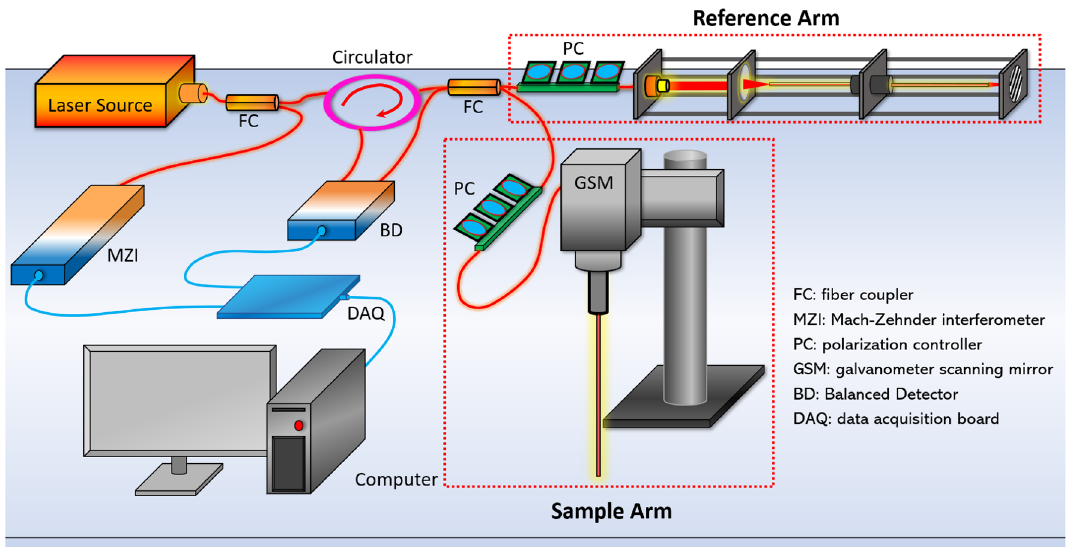
Figure 4. Schematic of forward-view OCT endoscope